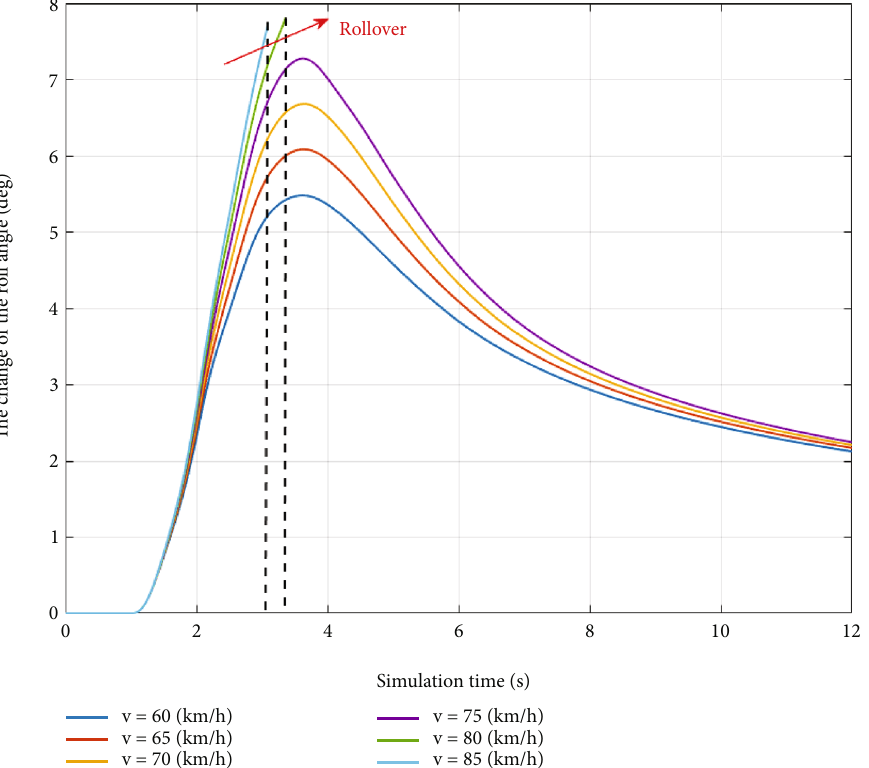
Figure 8: The change of the roll angle (the second case — velocity